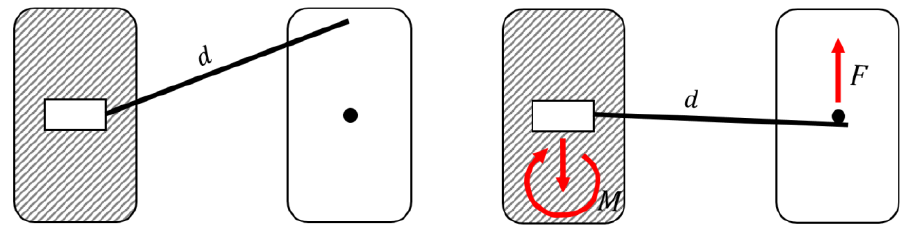
Figure 1. Force system of a cantilever. Left: Cantilever in a neutral position with a specific length ( d ). Right: Activated cantilever generating a single force ( F ) on one side and a force and a moment ( M ) on the other side.